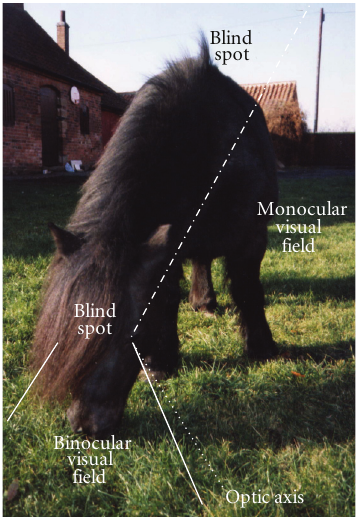
Figure 1: The position and extent of the binocular overlap in the region of the inferior visual field of the horse (approx. 65 ◦ : [16]). The extent of the monocular visual field, blind spots, and angle of the optic axis (approximately 40 ◦ from the midline: [15]) are also